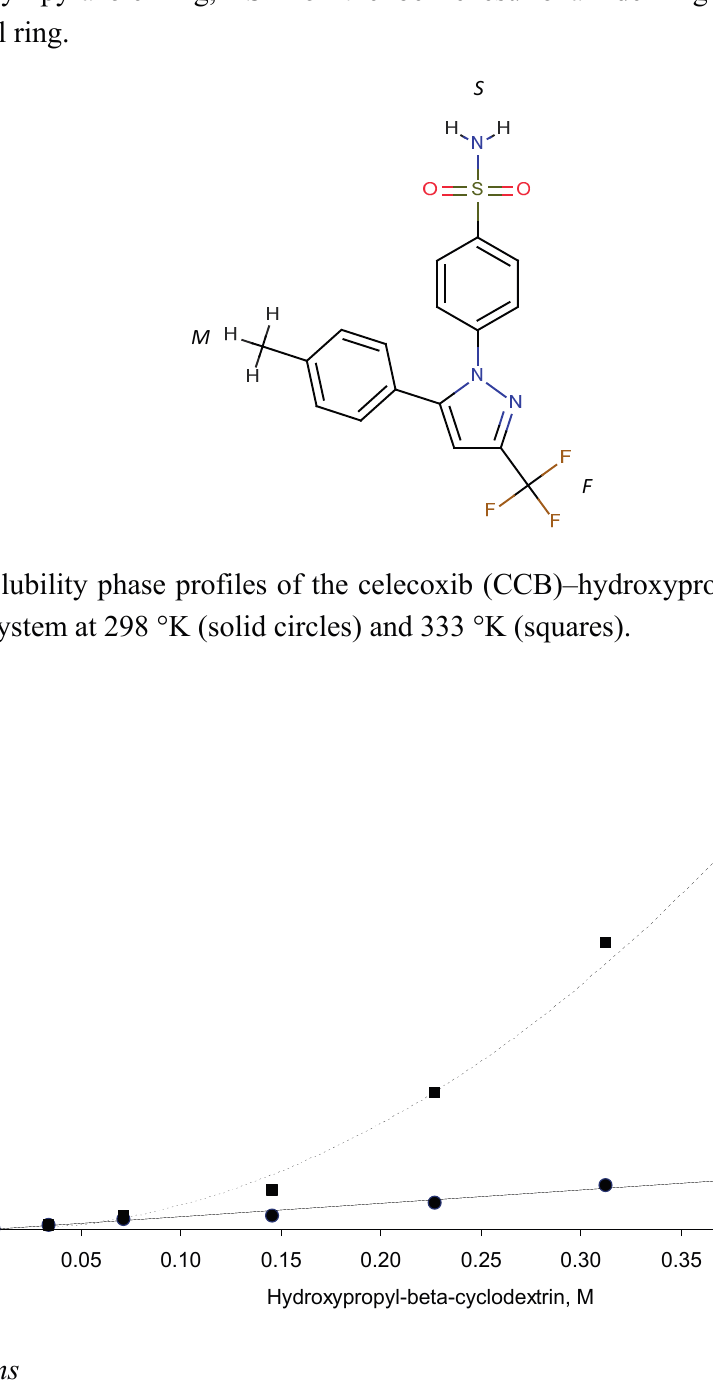
Figure 1. Chemical structure of celecoxib. Three ring structures are denoted as “F” for the trifluoromethyl pyrazole ring, “S” for the benzenesulfonamide ring and “M” for the methylphenyl ring.